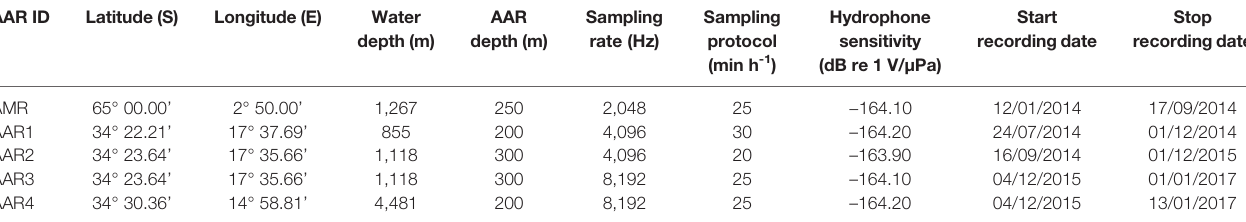
TABLE 1 | Summary of deployment details and recording settings of the fi ve autonomous acoustic recorders (AARs) used in this study. AAR ID Latitude